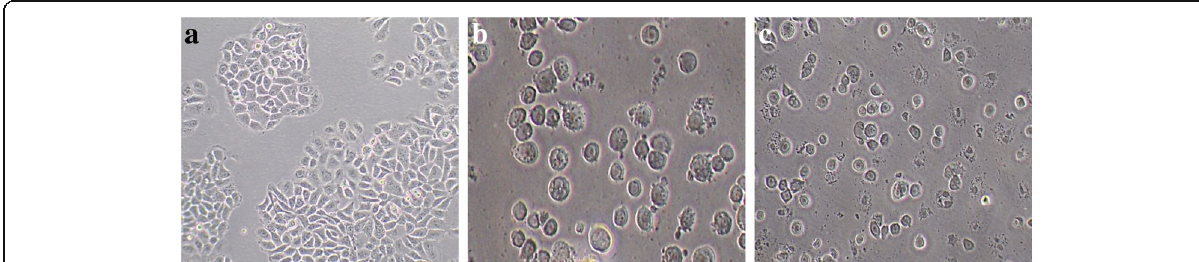
Fig. 4 Phase contrast microscopy ( a ) HepG2 cells with no treatment ( b ) HepG2 cells treated with 10 μ M camptothecin ( c ) HepG2 cells treated with IC 50 (75.864 μ g/ml) of the herbal combination